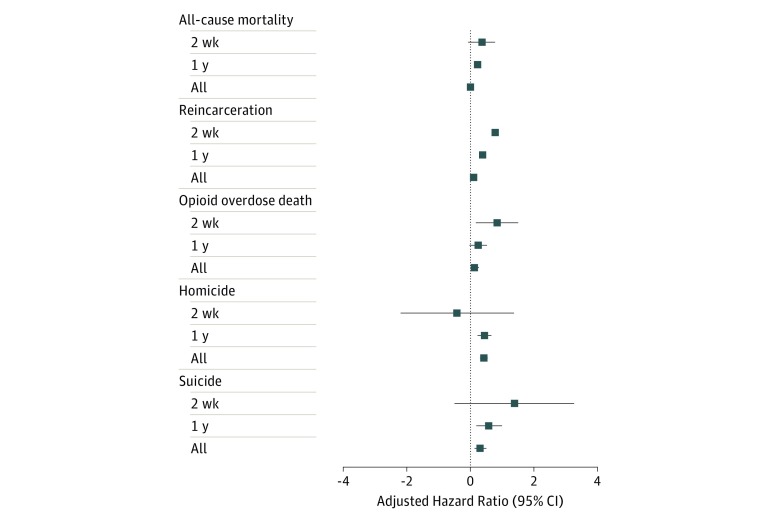
Association of Restrictive Housing During Incarceration With Mortality After Release and Reincarceration in North Carolina, 2000-2016All hazard ratios are adjusted for sex, race, and time-varying factors including age, prior incarcerations, time in incarceration, violence-related convictions, drug-related convictions, mental health screening recommendation, and mental health treatment receipt. The x-axis is on a logarithmic scale. Whiskers represent 95% CIs.